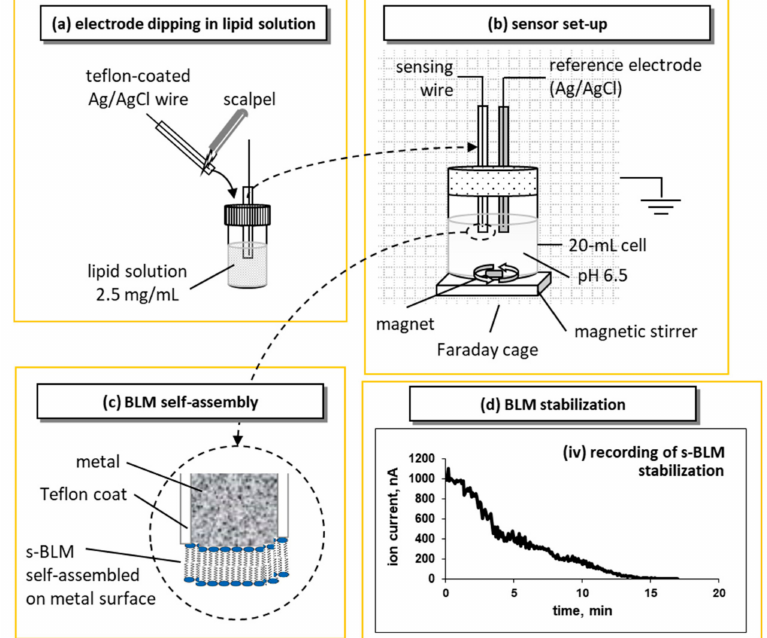
Figure 2. Schematic of the sensor, measurement setup, and lipid self-assembly process (not drawn to scale): ( a ) the sensing electrode is tipped with a scalpel and immediately immersed in lipid